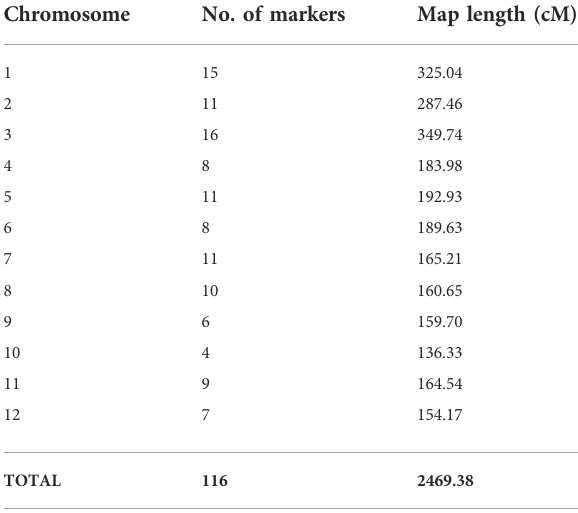
TABLE 2 Chromosome-wise number of the markers used for construction of linkage map, map length, and average marker